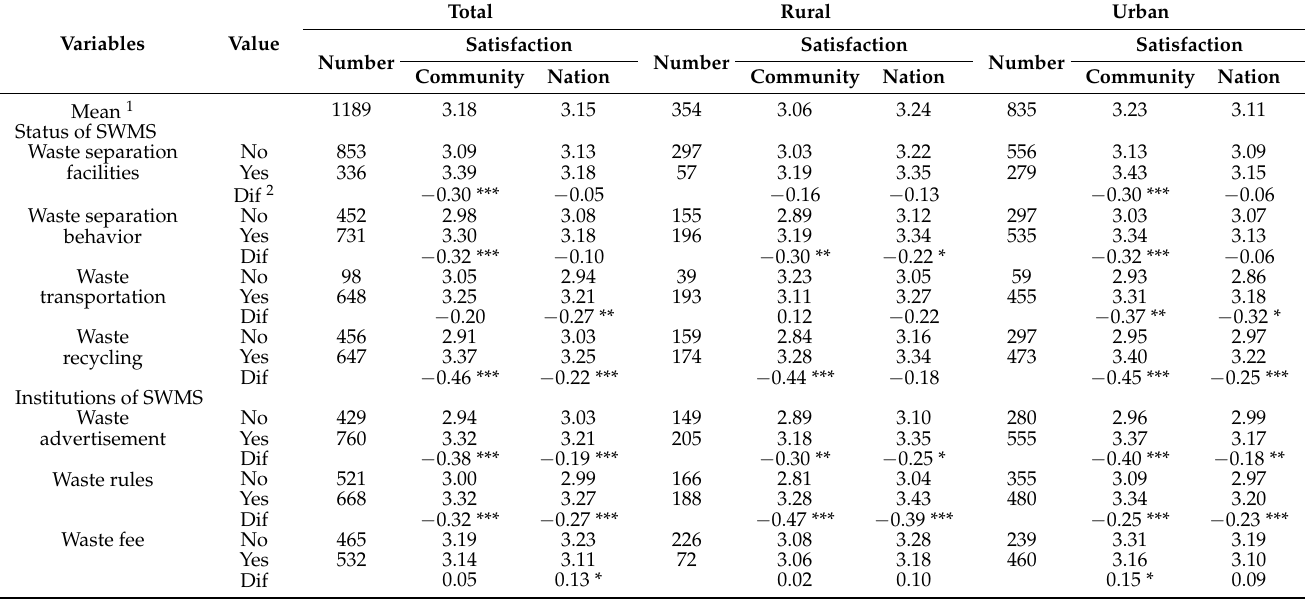
Table 3. Solid waste management services and satisfaction with community and national SWMS among rural and urban regions in